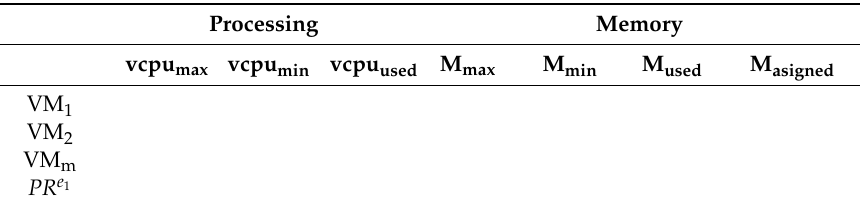
Table 1. Summary of information on physical